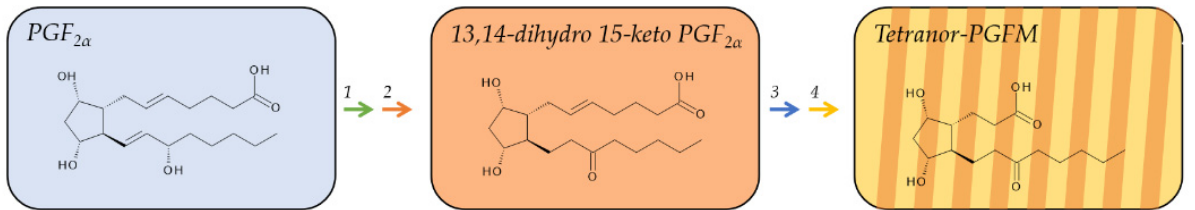
Figure 4. Major metabolic pathway of PGF 2 α . Metabolites on a red background are regarded as major plasma metabolites; metabolites on a yellow background are major urinary metabolites. The red arrow indicates reduction, and the green, blue, or yellow arrows oxidation reactions. 1, 15-hydroxyprostaglandin Dehydrogenase (15-PGDH, EC 1.1.1.141); 2, 15 ‐ oxo ‐ prostaglandin Δ 13 ‐ reductase (EC 1.3.1.48); 3, enzymatic β‐ oxidation; 4, enzymatic ω‐ oxidation.